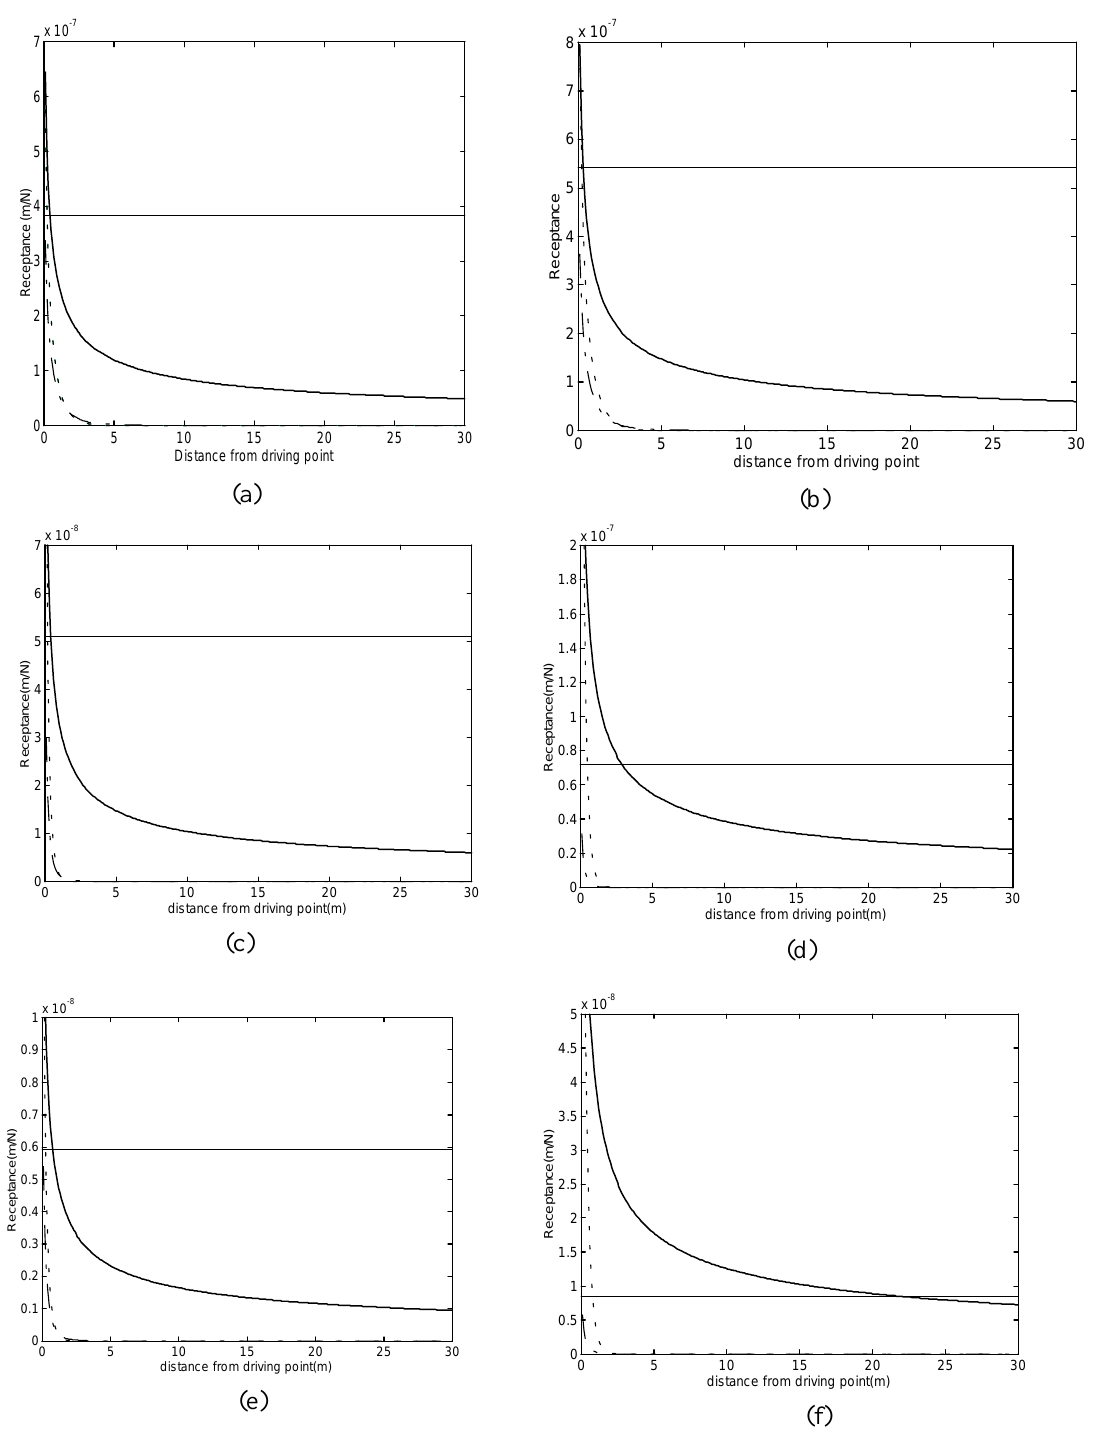
Fig. 10. The contribution to the response (receptance) of steel pates in water from different waves at frequencies 4 Hz (a, b), 50 Hz (c, d) and 100 Hz (e, f,). The left side figure for each frequency is with plate thickness 0.02 m while right side is 0.04 m. , free wave contribution; − − − , evanescent wave contribution; − - − , the acoustic contribution. —, point drive